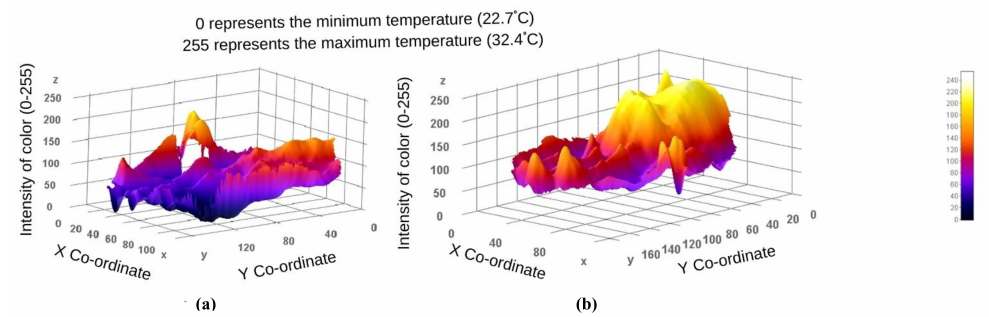
Figure 4. The 3D surface plot for the hand thermography of ( a ) tremor-affected and ( b ) normal hand of PD